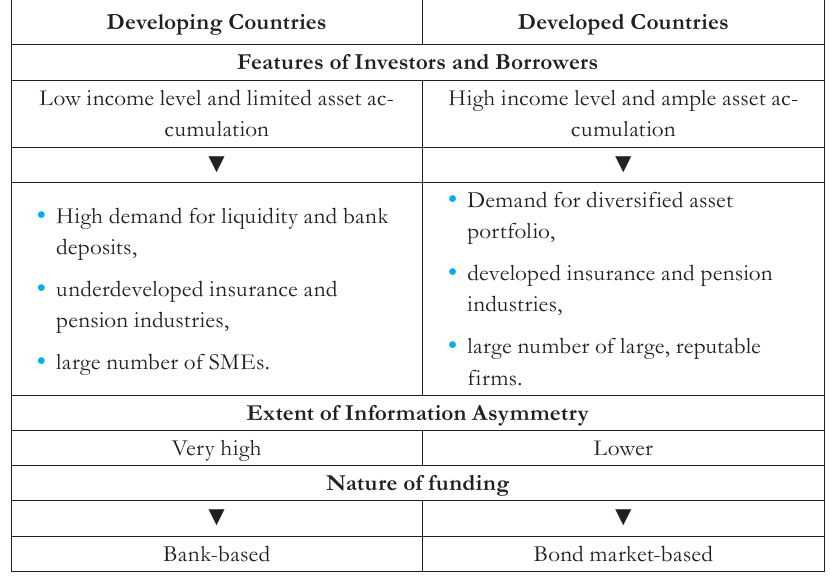
Fig. 1 - Phases of economic and financial system development and formation of business financing. Source: own, based on Yoshitomi and Shirai